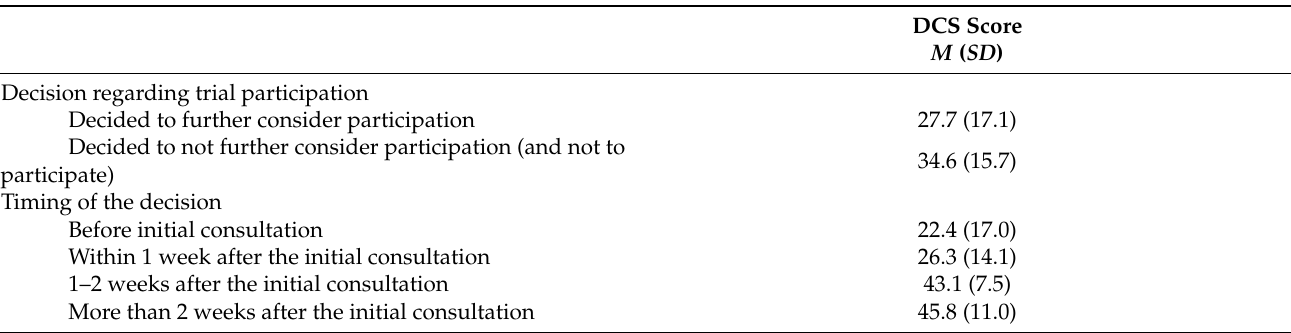
Table 4. Mean DCS score per group for the categorical variables (i.e., decision and timing of the